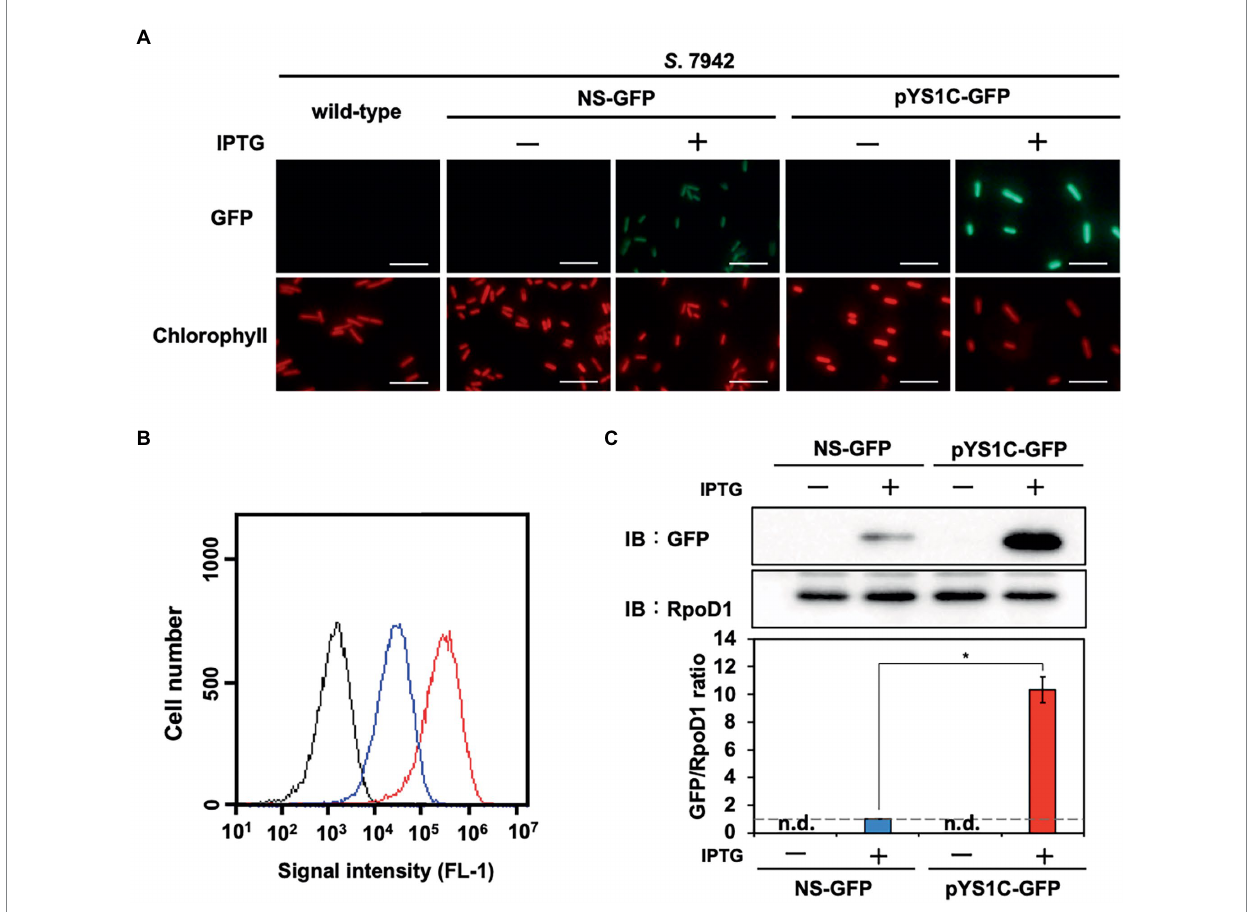
FIGURE 2 Comparison of expression performance between chromosome and pYS1 plasmid by the GFP reporter system in S . 7942. The GFP expression levels in the pYS1C-GFP transformant were compared to Synechococcus elongatus PCC 7942 ( S . 7942) wild-type and NS-GFP strains expressing GFP at the chromosomal neutral site. GFP expression was induced by the addition of 1 mM IPTG (final concentration). (A) Fluorescence microscopy images. The GFP and chlorophyll fluorescence images are shown. White bar, 10 μ m. (B) FACS analysis of the GFP fluorescence. Signal intensity of FL-1 indicating GFP fluorescence in the wild-type (black), NS-GFP (blue), and pYS1-GFP (red) strains are shown. (C) Western blot analysis. The protein extracts obtained from wild-type, NS-GFP, and pYS1C-GFP strains were subjected to SDS-PAGE and analyzed by western blotting using antibodies against GFP. RpoD1 was used as an internal control. The signal intensities of GFP were normalized to those of RpoD1, and the ratio the GFP signal to NS-GFP was set to 1. Bars represent the mean ± SEM ( n = 3; p < 0.05).